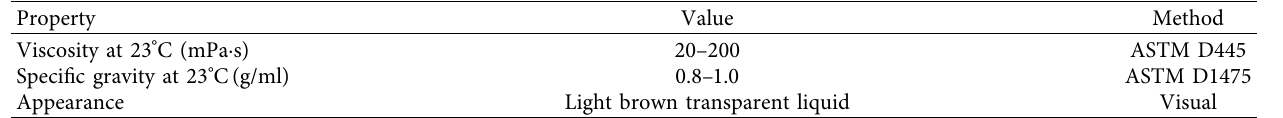
Table 2: Properties of part B in CME.